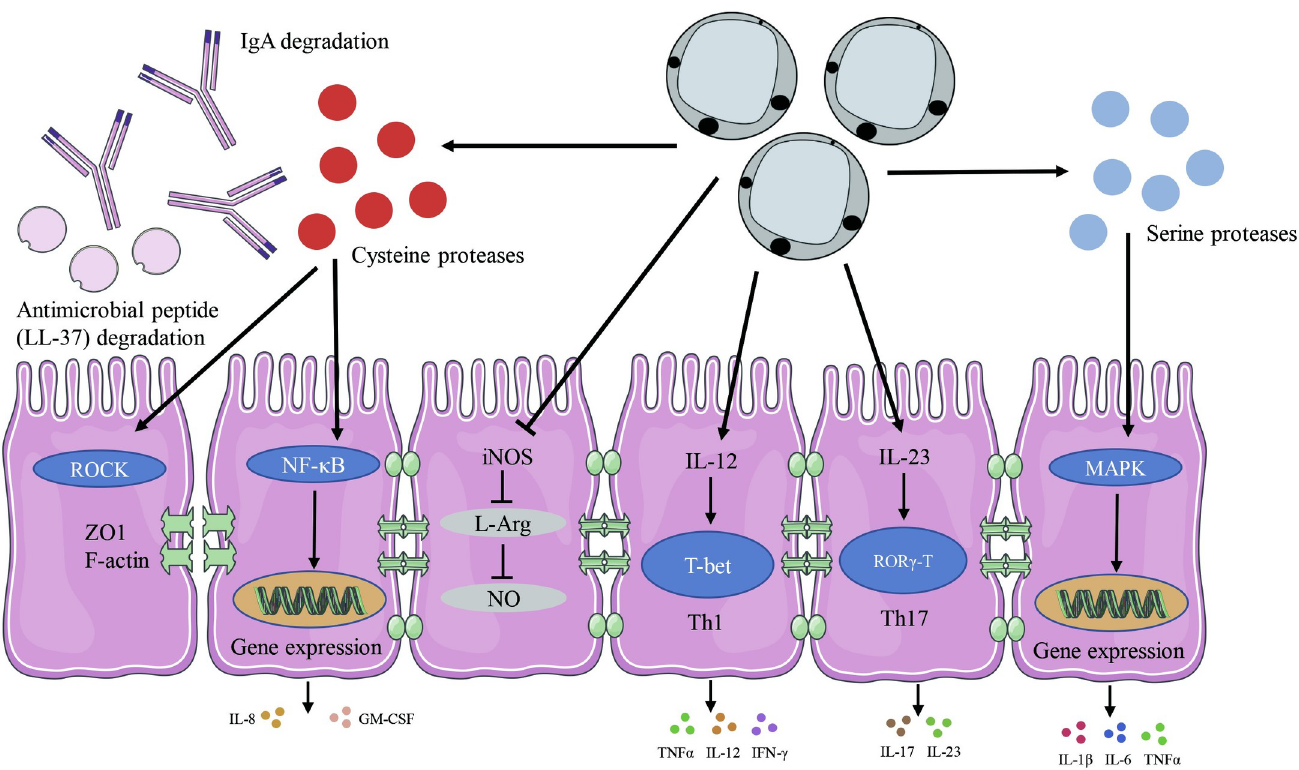
Fig 1. Blastocystis -mediated regulation of immune responses and homeostasis as characterized by studies using in vitro systems and experimental rodent models. This illustration simplifies the many interactions and pathways involved in Blastocystis colonization or infection in host cells. Cysteine proteases produced by Blastocystis are able to degrade IgA and AMP (LL-37). Blastocystis can also influence the gene expression of pro-inflammatory cytokines by regulating the NF- κ B and MAPK pathways. Blastocystis evades host NO antiparasitic response by inhibiting iNOS to convert arginine to NO. Blastocystis can induce Th1 and Th17 cells responses and their signature cytokines release. AMP, antimicrobial peptide; GM-CSF, granulocyte-macrophage colony-stimulating factor; IFN γ , interferon gamma; IgA, immunoglobulin A; IL, interleukin; iNOS, inducible nitric oxide synthase; L-Arg, L-Arginine; MAPK, mitogen-activated protein kinase; NF- κ B, nuclear factor- κ B; NO, nitric oxide; Th, T helper; TNF α , tumor necrosis factor alpha; ZO1, zonula occludens-1.